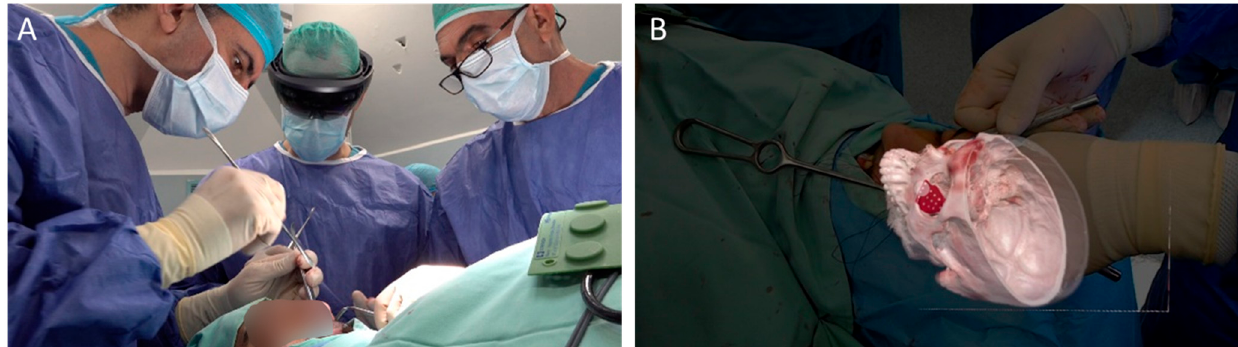
Figure 11. Augmented reality for orbital reconstruction. A surgeon is wearing the head-mounted glasses ( A ). Visualization and projection of 3D data within the operative field, depicting co-registration of the PSI onto the orbital fracture ( B ).